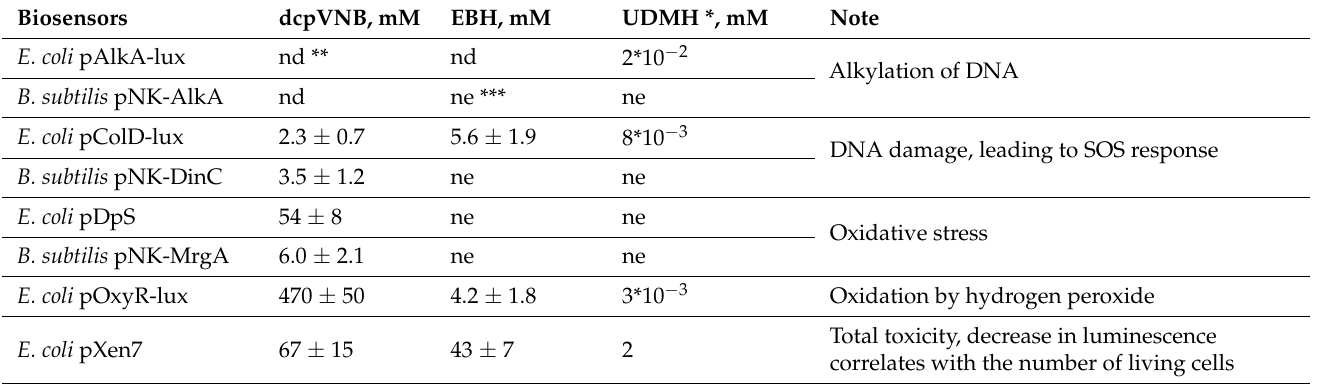
Figure 4. Typical kinetic curves of luminescence of E. coli MG1655 pDps ( A ), B. subtilis 168 pNK-MrgA ( B ), and E. coli MK2022 pDps ( C ) cells after addition of dcpVNB. “Neg.ctrl.”—control biosensor cells without addition of toxicant; “H 2 O 2 10uM”, “H 2 O 2 100uM” and “H 2 O 2 10mM”—hydrogen peroxide added to a final concentration of 10 µ M, 100 µ M and 10 mM, respectively; “dcp100”, “dcp30”, “dcp10”, and “dcp1”—dcpVNB added to a final concentration of 100, 30, 10, and 1 mg/mL, respectively. Table 2. Threshold concentrations for dcpVNB, EBH, and UDMH detectable with lux -biosensors, used in this study. * Concentrations were obtained earlier [10,36]. ** ”nd”—not determined. ***“ne”- not